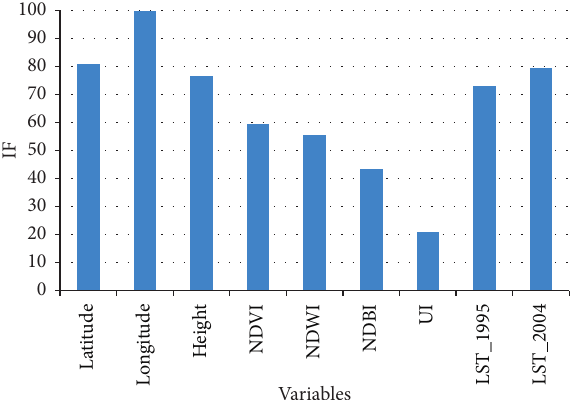
Figure 7: The important factor of input